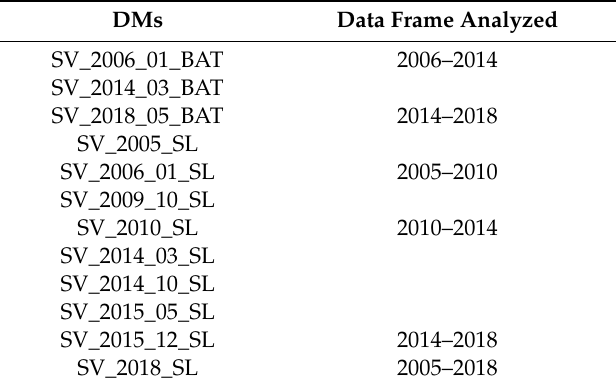
Table 2. Input digital models and data frame analyzed; the name of each digital model used is expressed as the test site ID, such as San Vincenzo = SV, followed by the date of the survey (i.e., 2006_01 = January 2006), and the type of feature (BAT = Bathymetry, SL = Shoreline).